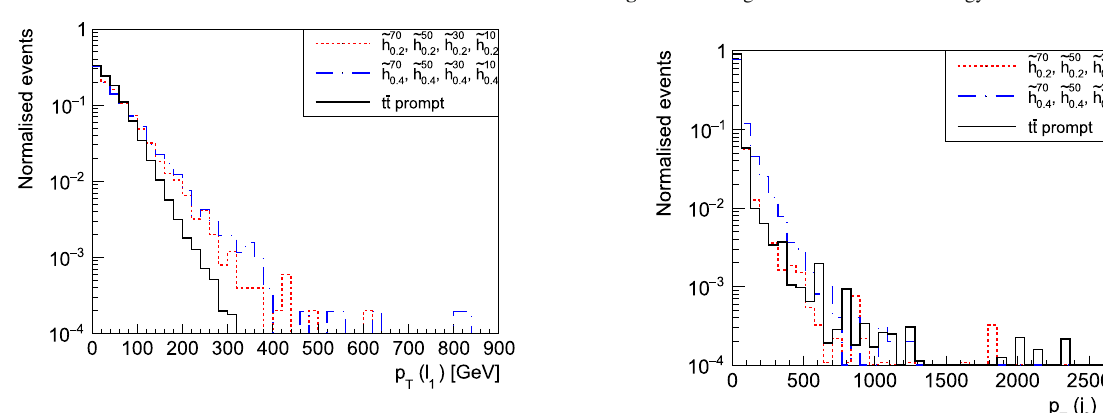
Fig. 37 Missing transverse hadronic energy MHT in the ˜ h 2 -like case